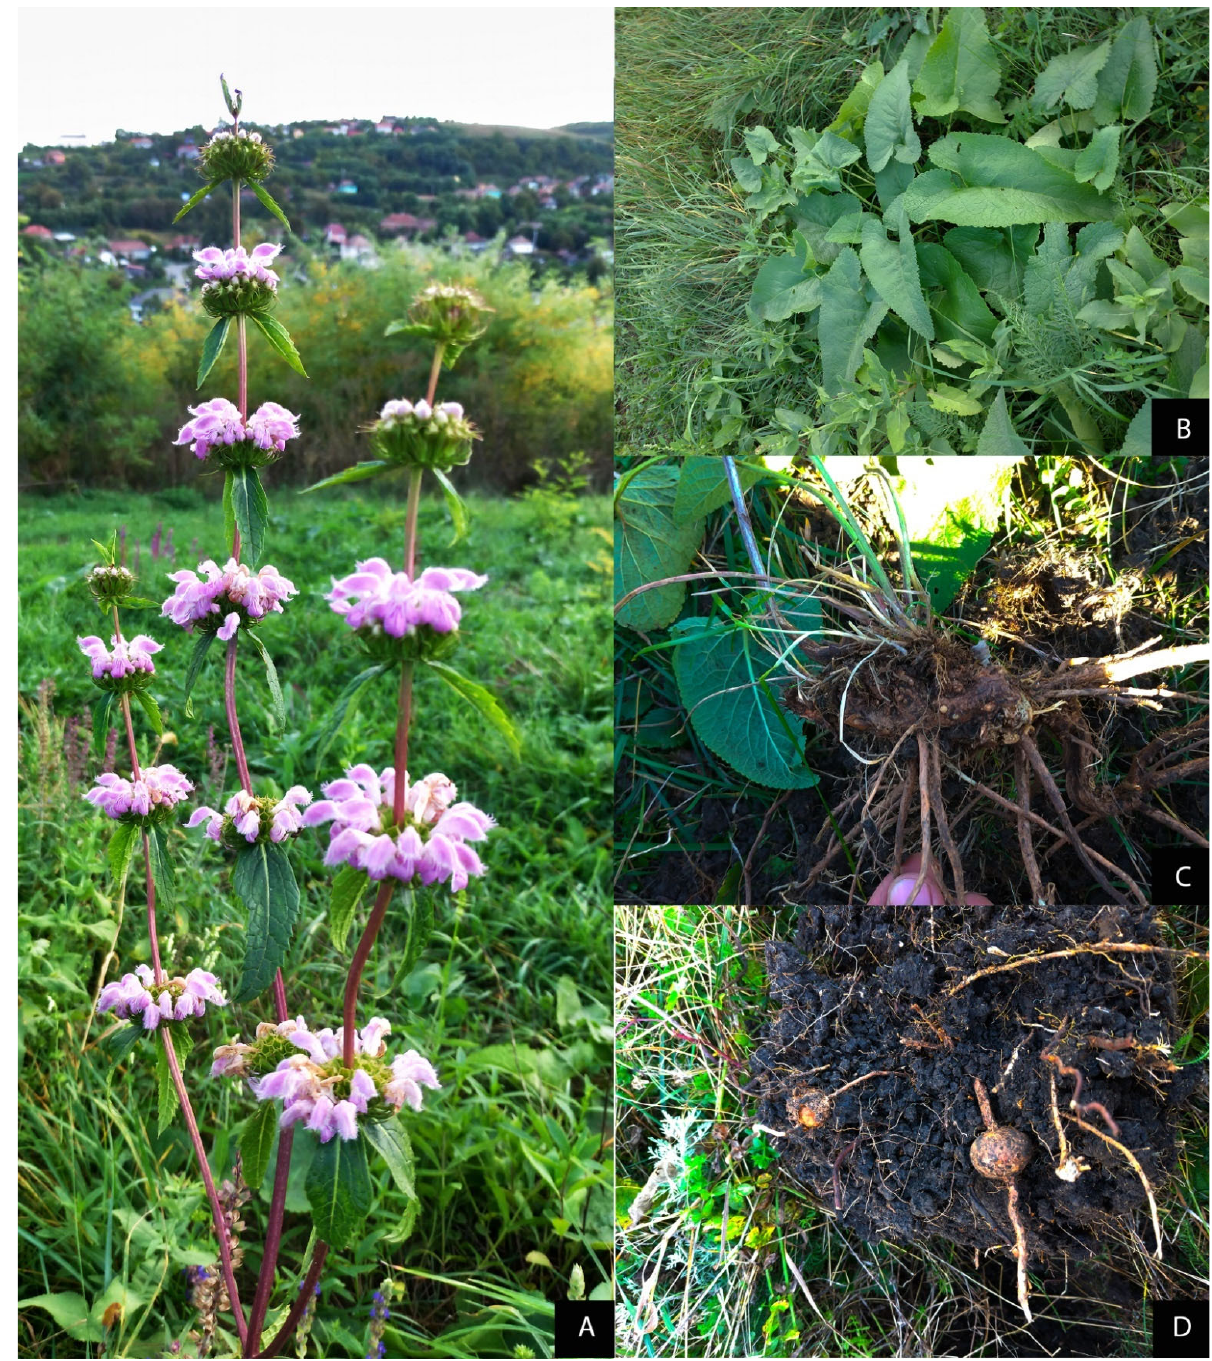
Figure 4. Phlomis tuberosa : ( A ) Pink flowers arranged in multiflora verticil; ( B ) triangular lower root leaves; ( C ) Brown rhizome with fibrous roots; ( D ) P. tuberosa tubers.